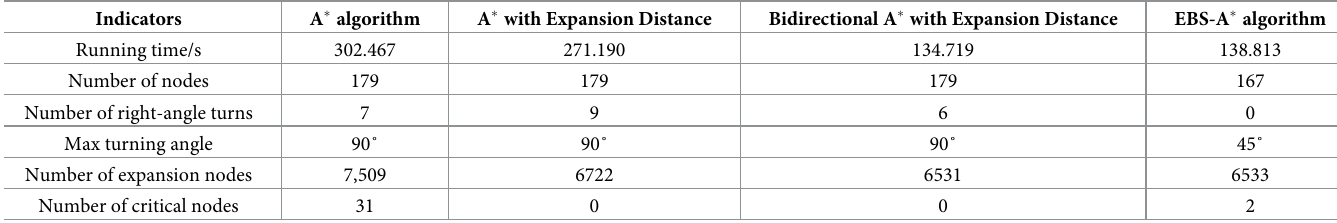
Table 3. Simulation results of four algorithms on a 100 × 100 map.